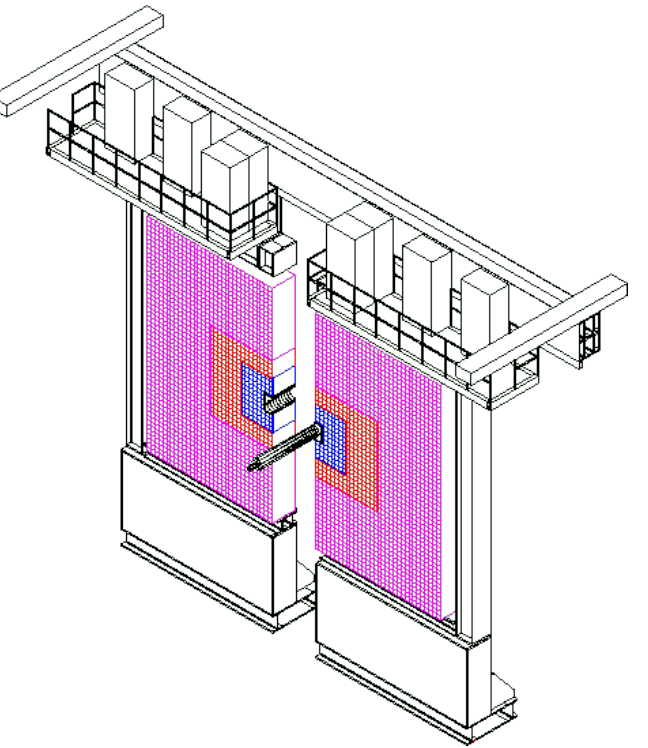
Figure 1. The electromagnetic calorimeter 3d-view from behind the detector towards the interaction point